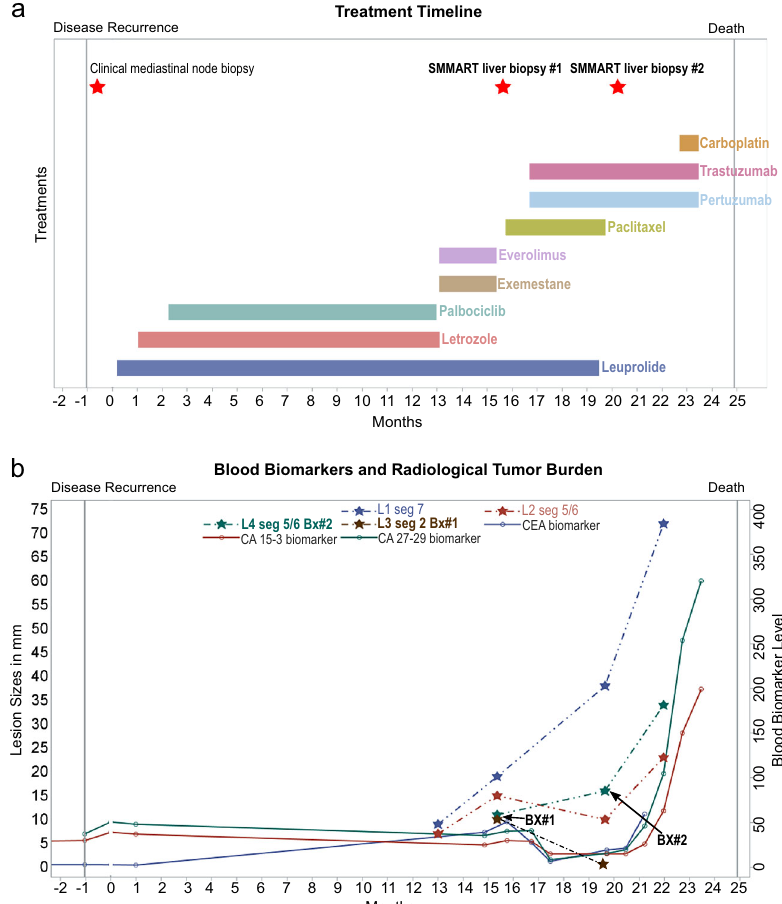
Fig. 1 Overview of clinical timeline and response. a Treatment (colored boxes) and biopsy (red stars) timeline, in months, following disease recurrence in the metastatic setting. b Timeline of blood biomarker levels (U/ml, solid lines) and lesion sizes (in millimeters) for four selected hepatic lesions (hatched lines). Study biopsy #1 (Bx#1) = Liver 3 segment 2 (L3 seg2); Study biopsy #2 (Bx#2) = Liver 4 segment 5/6 (L4